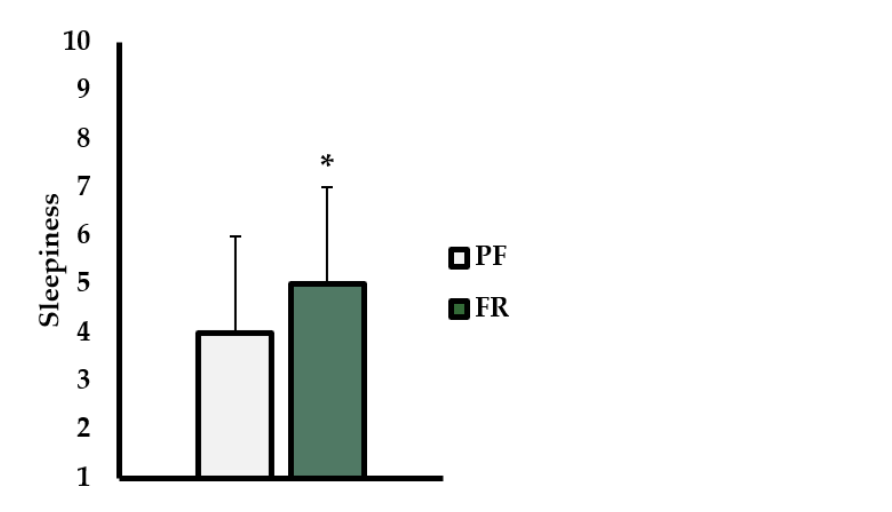
indicates statistically significant differences between trials. Table 1. Central visuomotor reaction time tests. Data are presented as mean (m) ± standard deviation